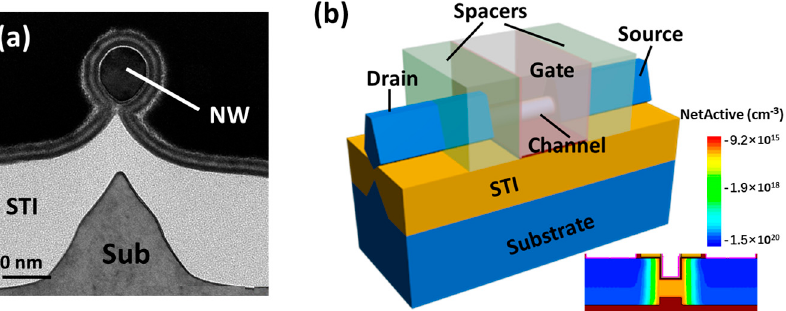
Figure 1. Device structure: ( a ) cross-sectional transmission electron microscopy (TEM) image per- pendicular to the channel, ( b ) schematic of the Gate-all-around (GAA) silicon nanowire (Si NW) metal oxide semiconductor field effect transistor (MOSFET) with a circular nanowire channel. Inset: Simulated doping profile of the